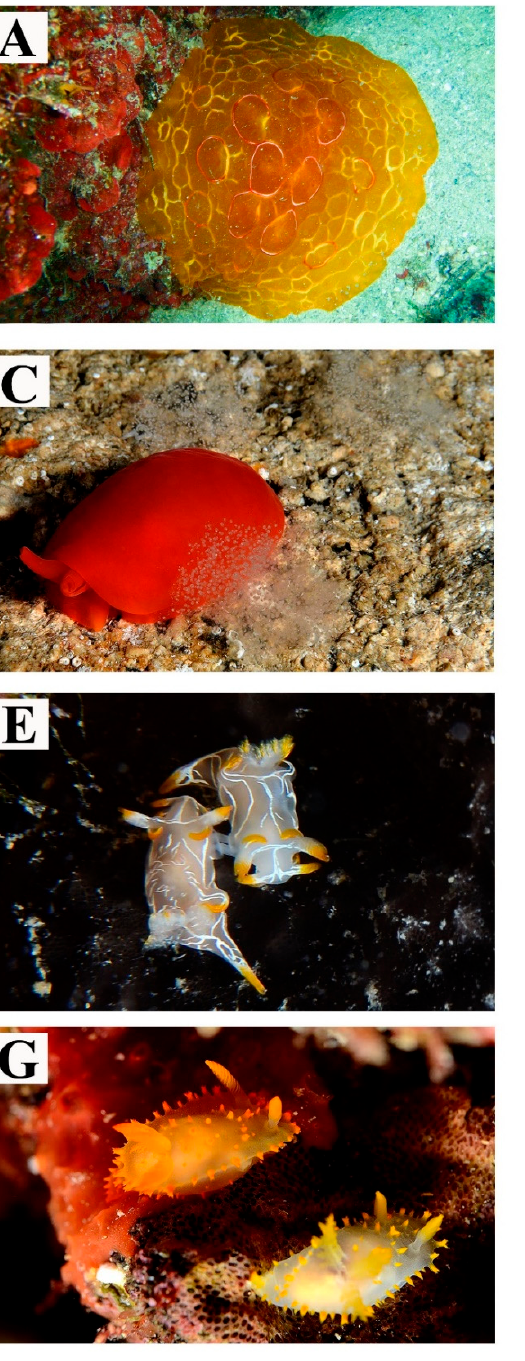
Figure 2. ( A ) Pleurobranchus testudinarius. St. 3 ( B ) Berthellina cf. edwardsii . St. 11. In the right-low Figure 2. A. Pleurobranchus testudinarius. St. 3 B. Berthellina cf. edwardsii . St. 11. In the right-low corner, corner, the internal shell (length: 4.2 mm). ( C ) Berthellina cf. edwardsii . St. 11 ( D ) Diaphorodoris the internal shell (length: 4.2 mm). C. Berthellina cf. edwardsii . St. 11 D. Diaphorodoris luteocincta. St. 11 luteocincta. St. 11 ( E ) Trapania lineata , mating individuals. St. 11 ( F ) Trapania maculata. St. 11 ( G ) Crimora E. Trapania lineata , mating individuals. St. 11 F. Trapania maculata. St. 11 G. Crimora papillata. St. 11 H. papillata. St. 11 ( H ) Crimora papillata , with spawn. St. Crimora papillata , with spawn. St. 11.